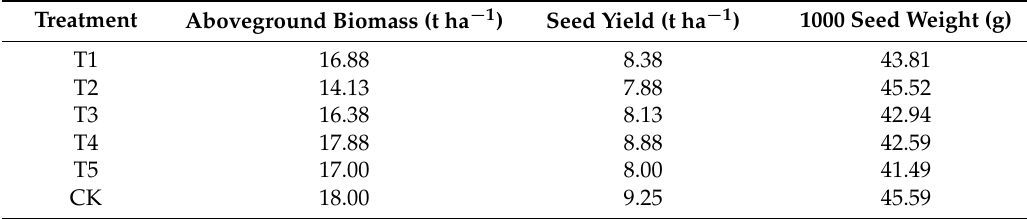
Table 4. Winter wheat aboveground biomass, seed yield, and 1000-seed weight under different irrigation